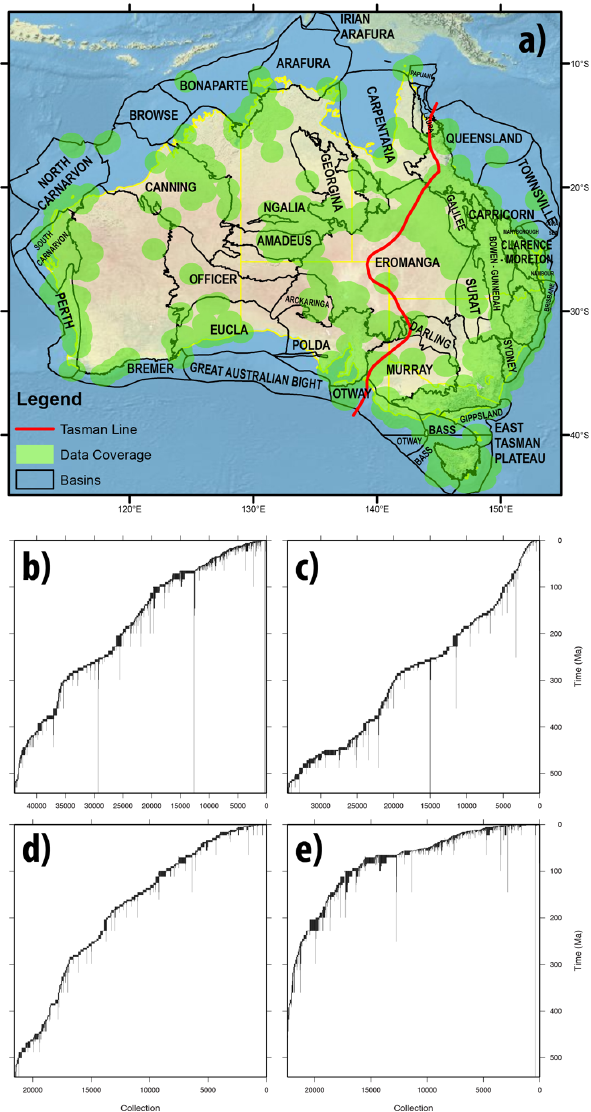
Fig. 5. (a) Data coverage with 100km buffer (green) from the Pa- leobiology Database for Australia, with basin outlines and politi- cal boundaries as reference. Temporal coverages of fossil collec- tions are for (b) general, (c) carbonate, (d) siliciclastic marine, and (e) terrestrial fossil collections, showing that the dataset sufficiently represents Phanerozoic biofacies.